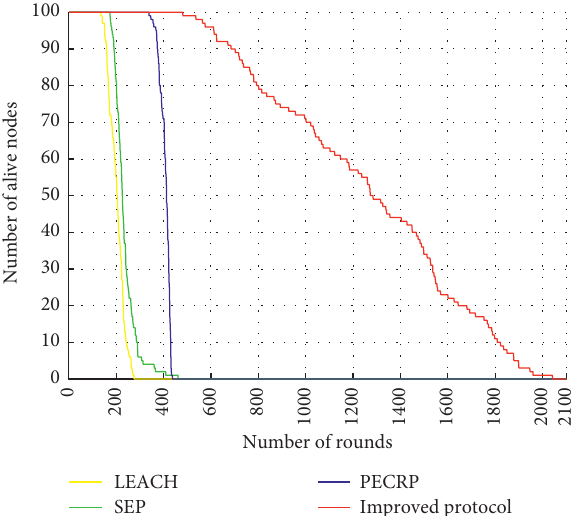
Figure 9: Comparison of live nodes in each round without power supply.